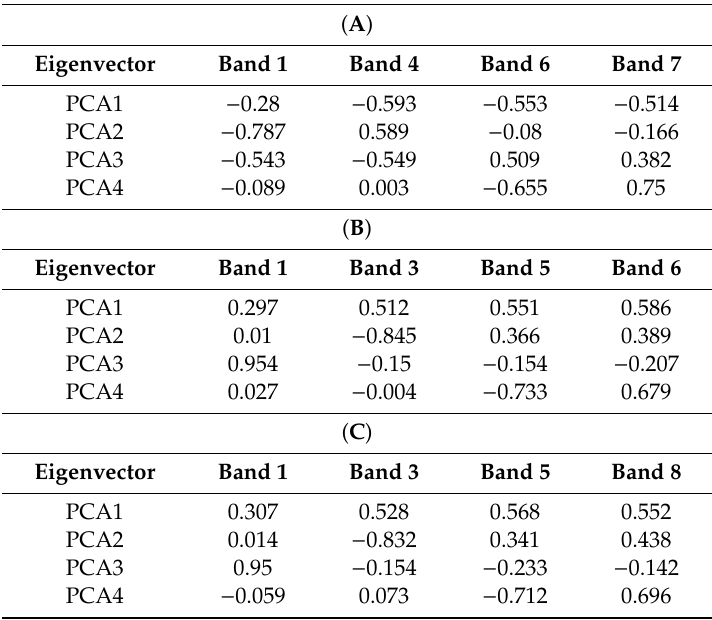
Table 5. The Eigenvector matrix values derived from PCA for mapping advanced argillic, argillic-phyllic and propylitic alteration zones using ASTER VNIR + SWIR bands. ( A ) Bands 1, 4, 6 and 7 for advanced argillic zone mapping; ( B ) Bands 1, 3, 5 and 6 for argillic-phyllic zone mapping; and ( C ) Bands 1, 3, 5 and 8 for propylitic zone